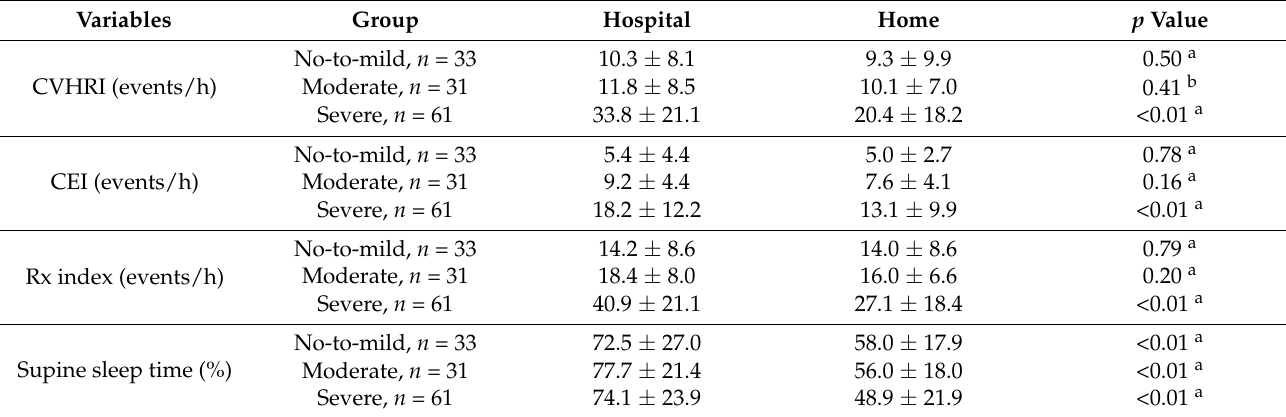
Table 2. Comparison of the sleep parameters obtained by RootiRx in hospital and home